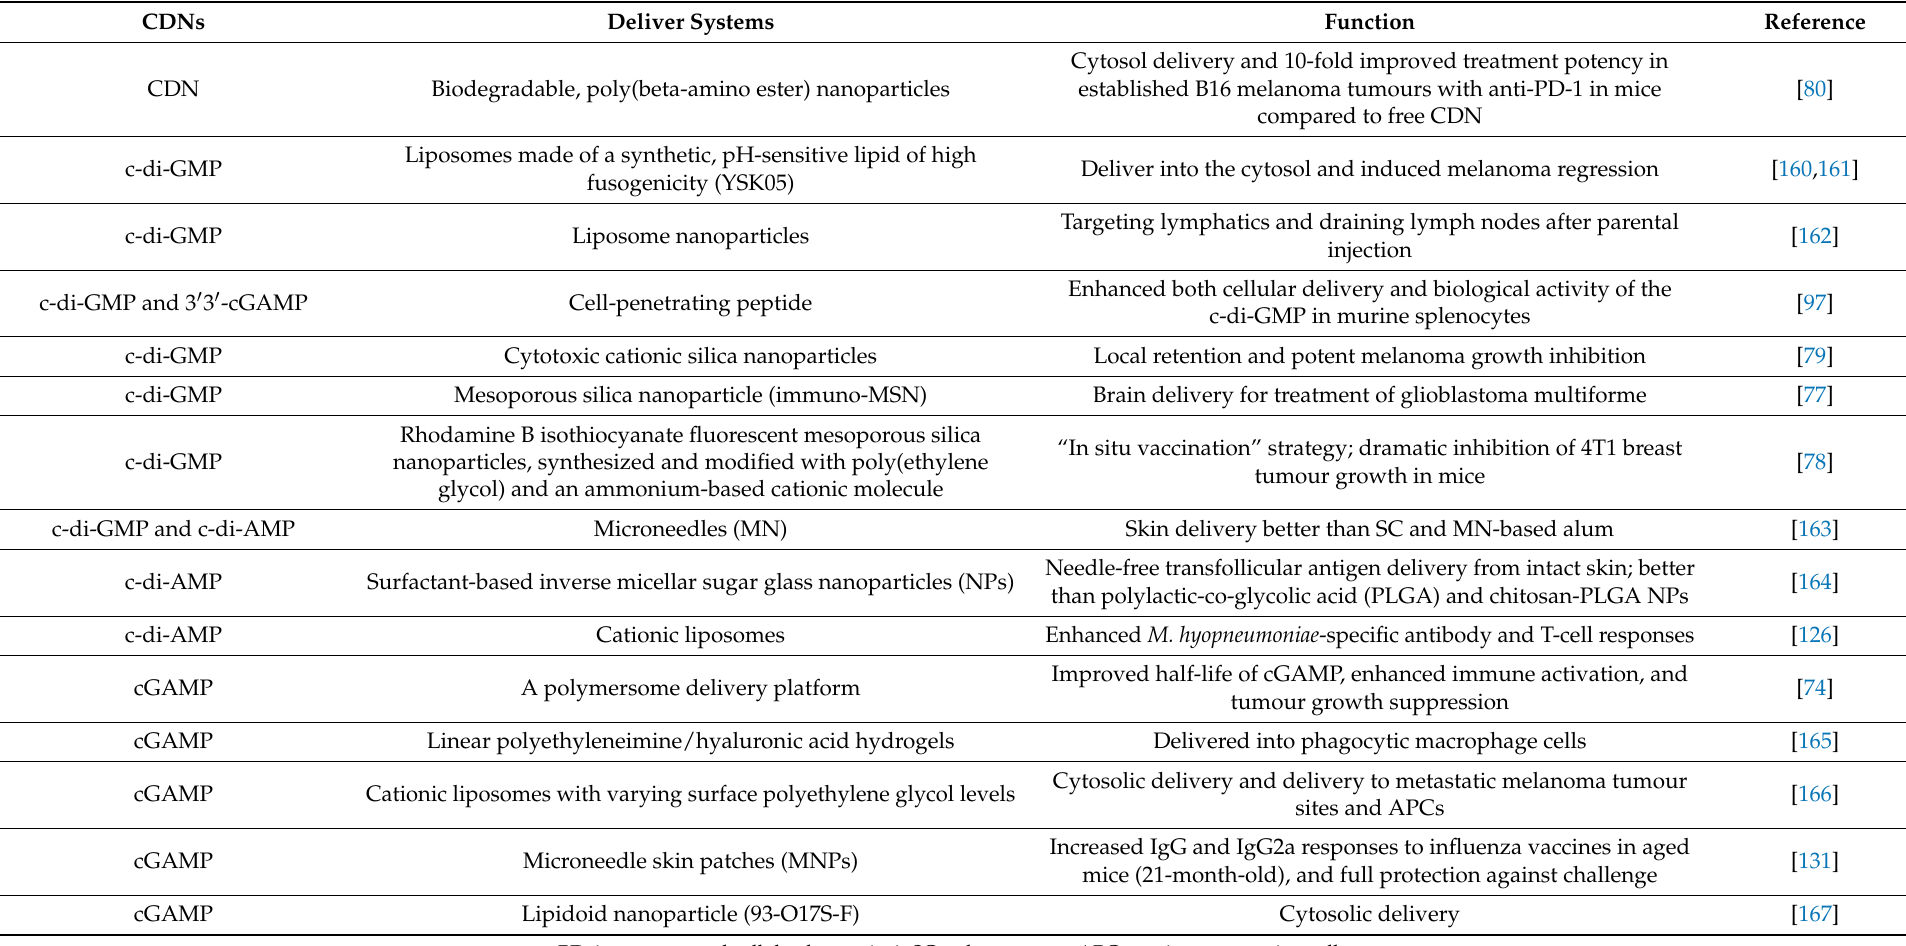
Table 2. Selected examples of cyclic dinucleotides (CDNs) delivery